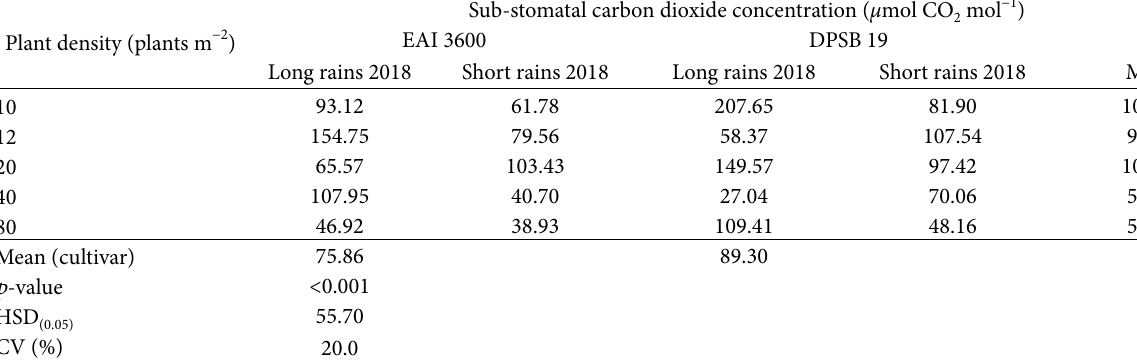
Table 5: Effect of plant density, cultivar and season on sub-stomatal carbon dioxide concentration ( µ mol CO